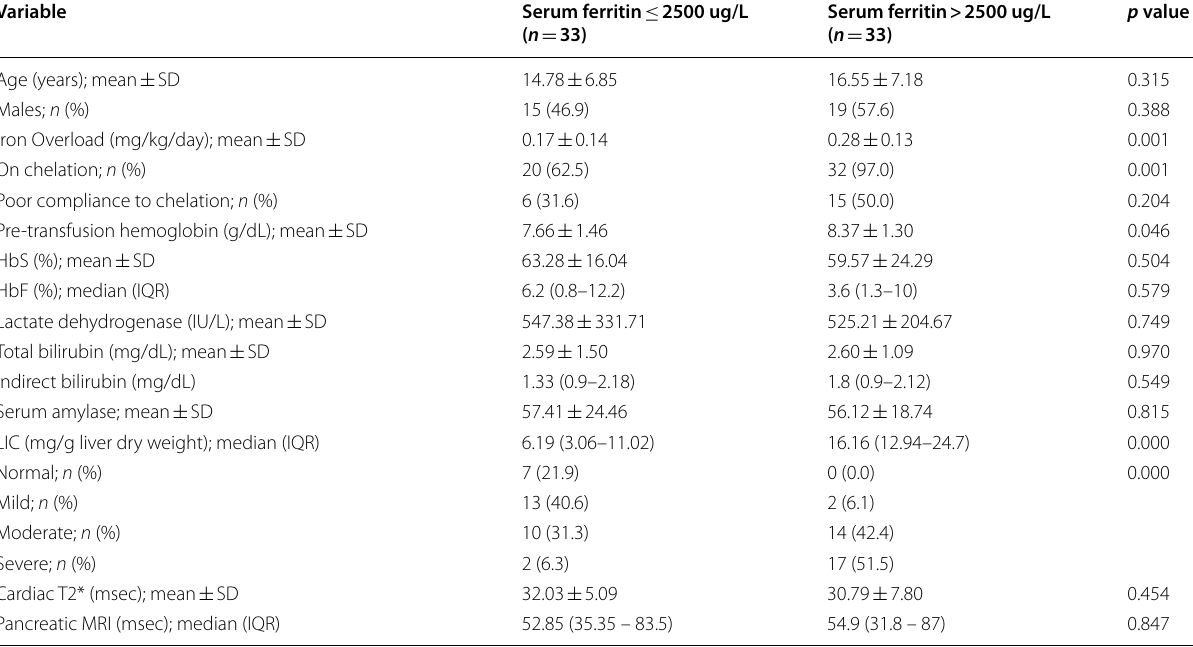
Table 3 Comparison between sickle cell disease patients who had serum ferritin